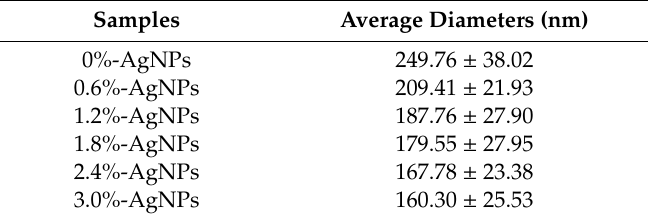
Figure 2. SEM images and diameter distributions of FK/PVA/PEO composite nanofibers with different AgNPs contents: ( A , a ) 0%-AgNPs, ( B , b ) 0.6%-AgNPs, ( C , c ) 1.2%-AgNPs,( D , d ) 1.8%-AgNPs, ( E , e ) 2.4%-AgNPs, ( F , f ) 3%-AgNPs. Table 1. Average diameters of FK/PVA/PEO composite nanofibers with different AgNPs contents.